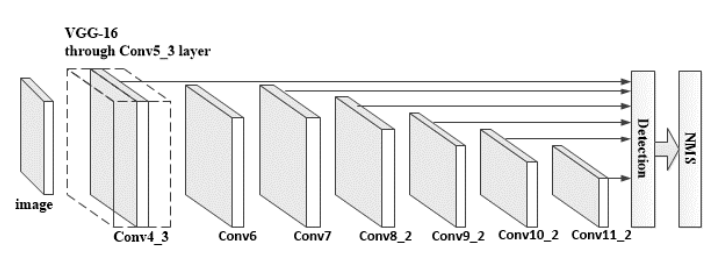
Figure 5. Network framework of